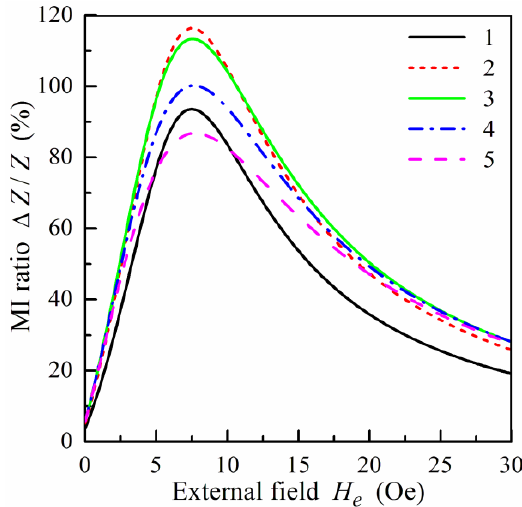
Figure 2. MI ratio, ∆ Z / Z , as a function of the external field, H e , for di ff erent frequencies, f : curve 1, f = 25 MHz; curve 2, f = 50 MHz; curve 3, f = 100 MHz; curve 4, f = 150 MHz; curve 5, f = 200 MHz. Parameters used for calculations are l = 1 cm, w = 0.02 cm, 2 d 0 = 500 nm, d 1 = 3 nm, d 2 = 100 nm, m = n = 4, M = 750 G, H a = 6 Oe, ψ = 0.1 π , σ 0 = σ 1 = 5 × 10 17 s − 1 , σ 2 = 3 × 10 16 s − 1 , and κ = 0.02.